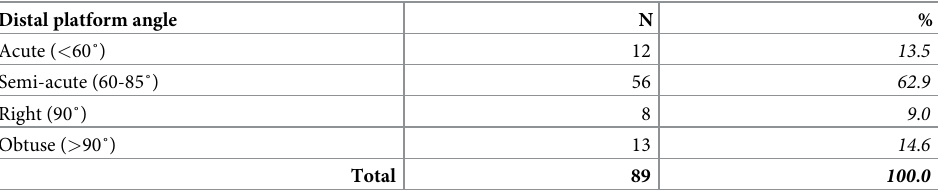
Table 7. Frequencies of distal platform angles on Tweefontein Nubian